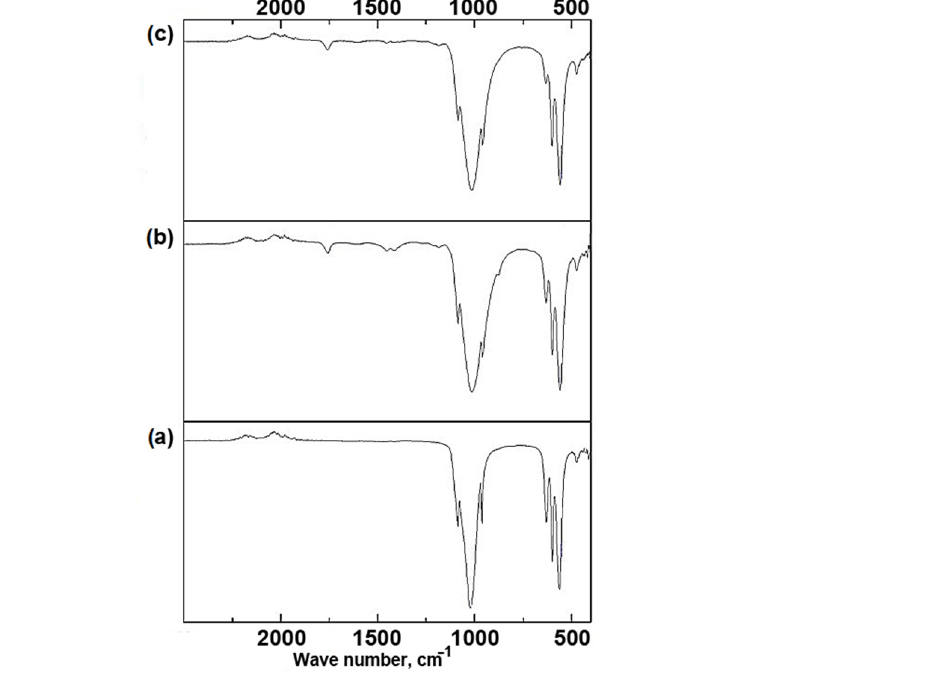
Figure 3. IR spectra of ( a ) Zn x HA (x = 0.1), ( b ) Zn x HA-PLGA (x = 0.1), ( c ) Zn x HA-PLGA (x = 0.5) samples.